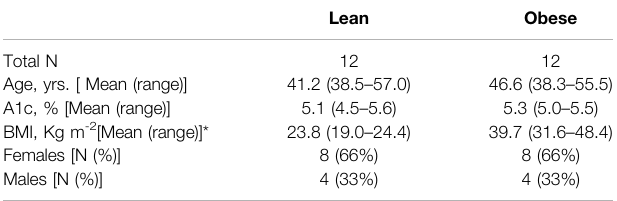
TABLE 1 | Description of research subjects.